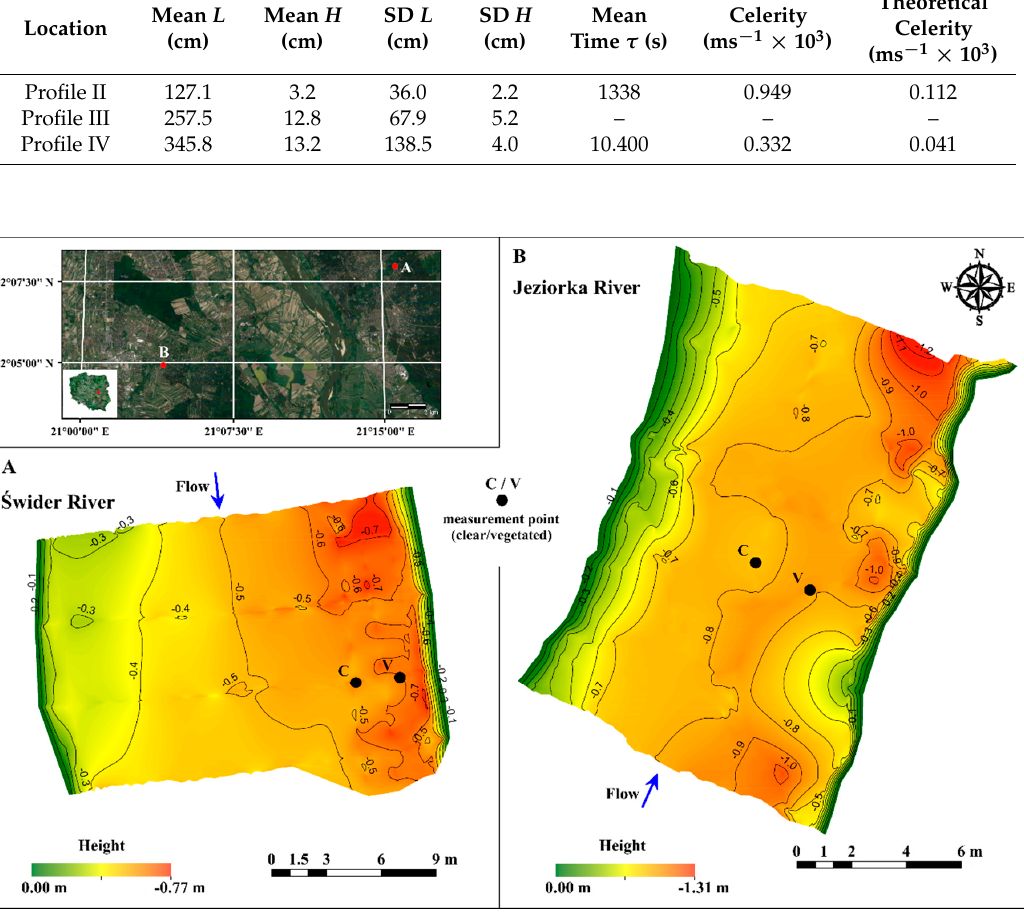
Figure 4. Bed morphology of studied sites in the ( A ) Ś wider River and ( B ) Jeziorka River.